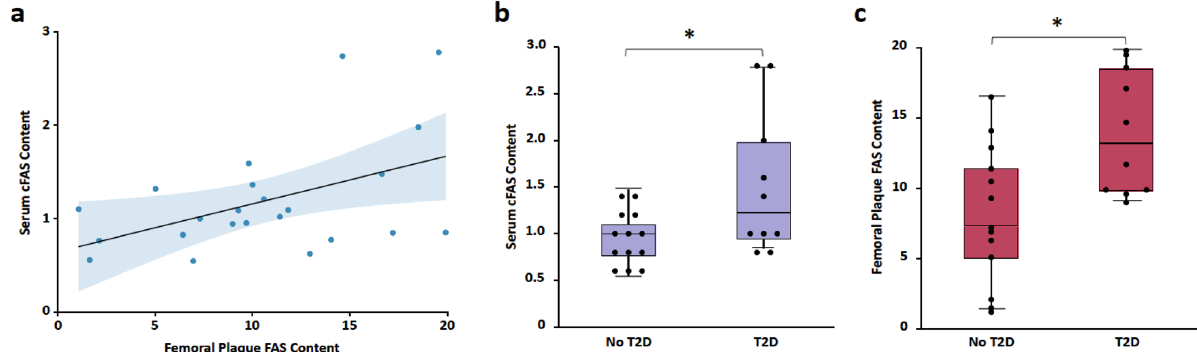
Figure 3. Correlation between FAS content in serum and femoral atherosclerotic plaques of patients with severe PAD . ( a ) Regression analysis of FAS content in the serum and plaque of patients with severe PAD 2 demonstrates a significant positive correlation ( R = 0.22; P = 0.023). FAS content is expressed as ratios relative to total serum or plaque protein content. ( b ) Comparison of patients with and without T2D demonstrates that cFAS content was significantly higher in patients with T2D compared to no T2D (1.51 ± 0.75 vs. 0.95 ± 0.29; P = 0.047). ( c ) Similarly, femoral plaque FAS content was significantly higher in patients with T2D (14.0 ± 4.46 vs. 8.11 ± 4.93; P = 0.013). Boxplot indicates interquartile range (IQR), median (horizontal line within box), and 1.5 IQR of upper quartile (top whisker) and lower quartile (bottom whisker). cFAS and plaque FAS content were expressed as ratios relative to total serum or plaque protein content, respectively. * P <